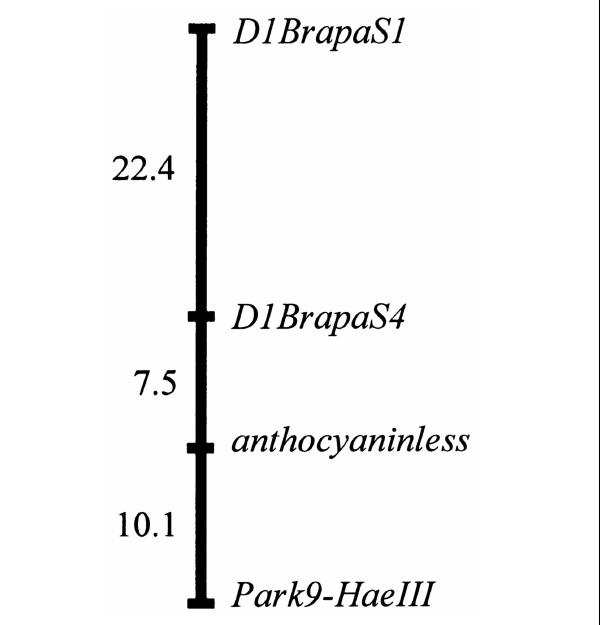
FIGURE 6 | Genetic map of the anthocyaninless locus relative toA09 marker reported in this paper. Map distances are Kosambi